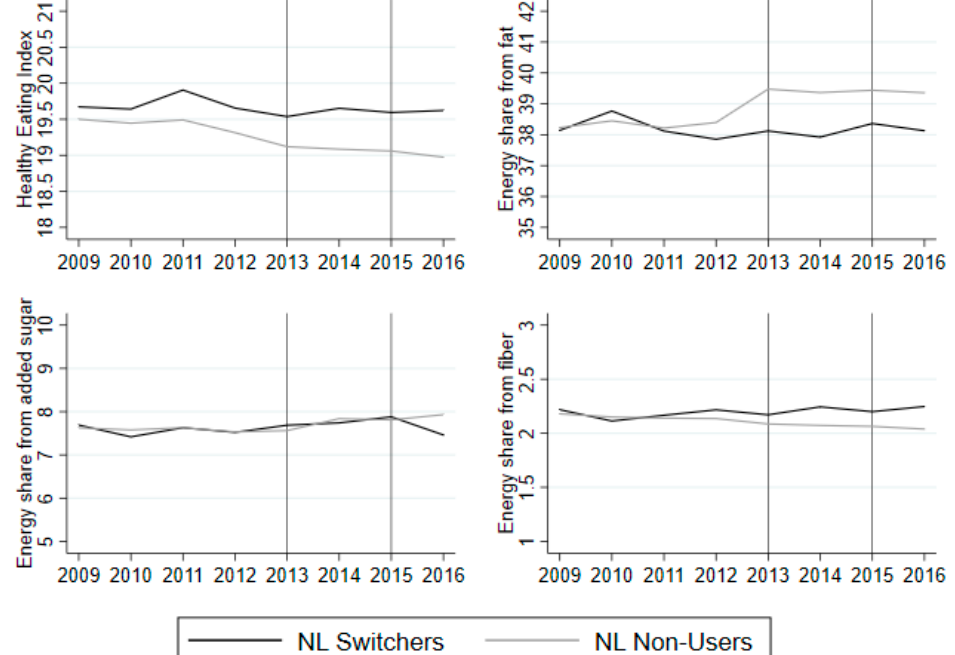
Figure 2. Average Healthy Eating Index (HEI) and nutrient shares from 2009 to 2016 for NL switchers (black) and non-users (grey). Note: The vertical lines indicate the years in which the questionnaires were sent to the panel. The average is based on households that answered the question on use of NL in 2013 and 2015. The averages are based on unbalanced panel from 2009 to 2016, as not all of the household stay in the panel from 2009 to 2016.